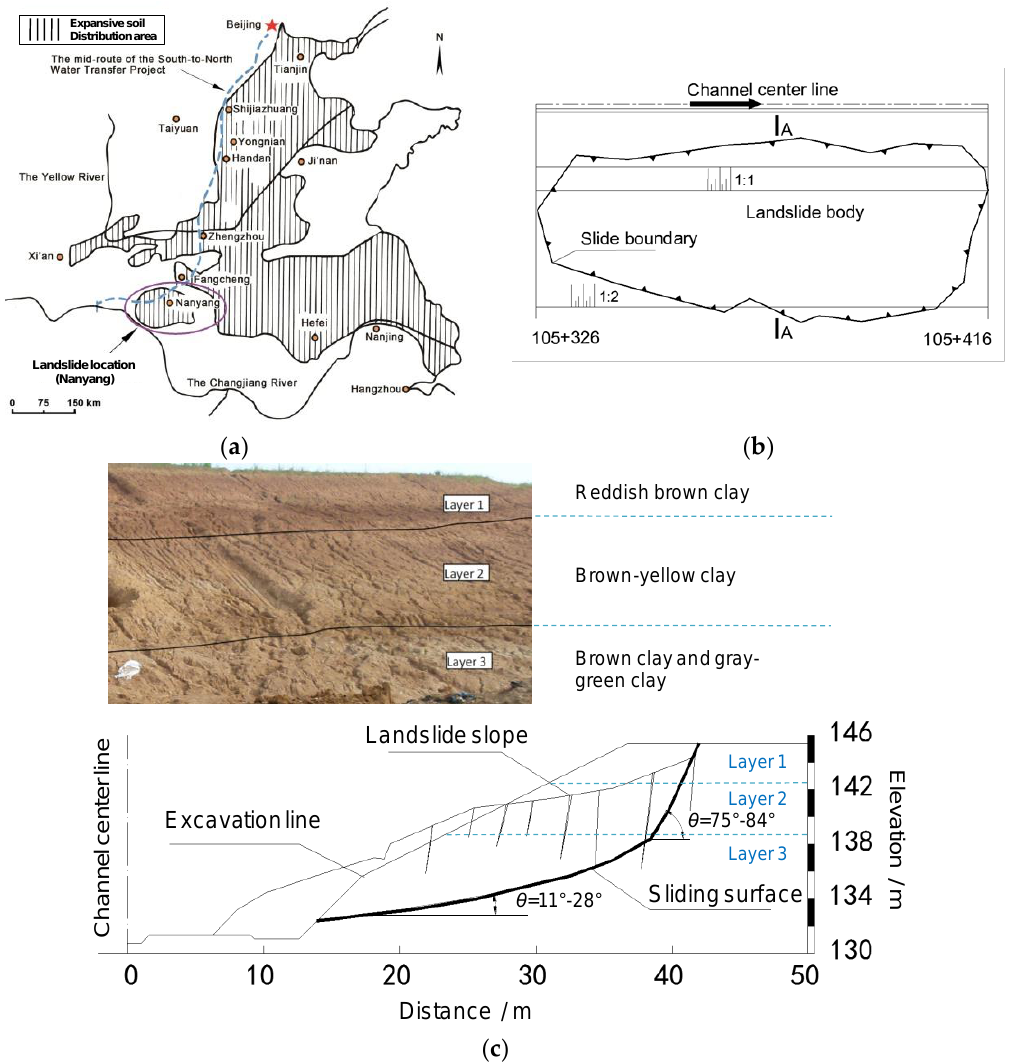
Figure 9. The landslide characteristics. ( a ) Site location; ( b ) landslide plan; ( c ) landslide profile and landslide engineering geological information.